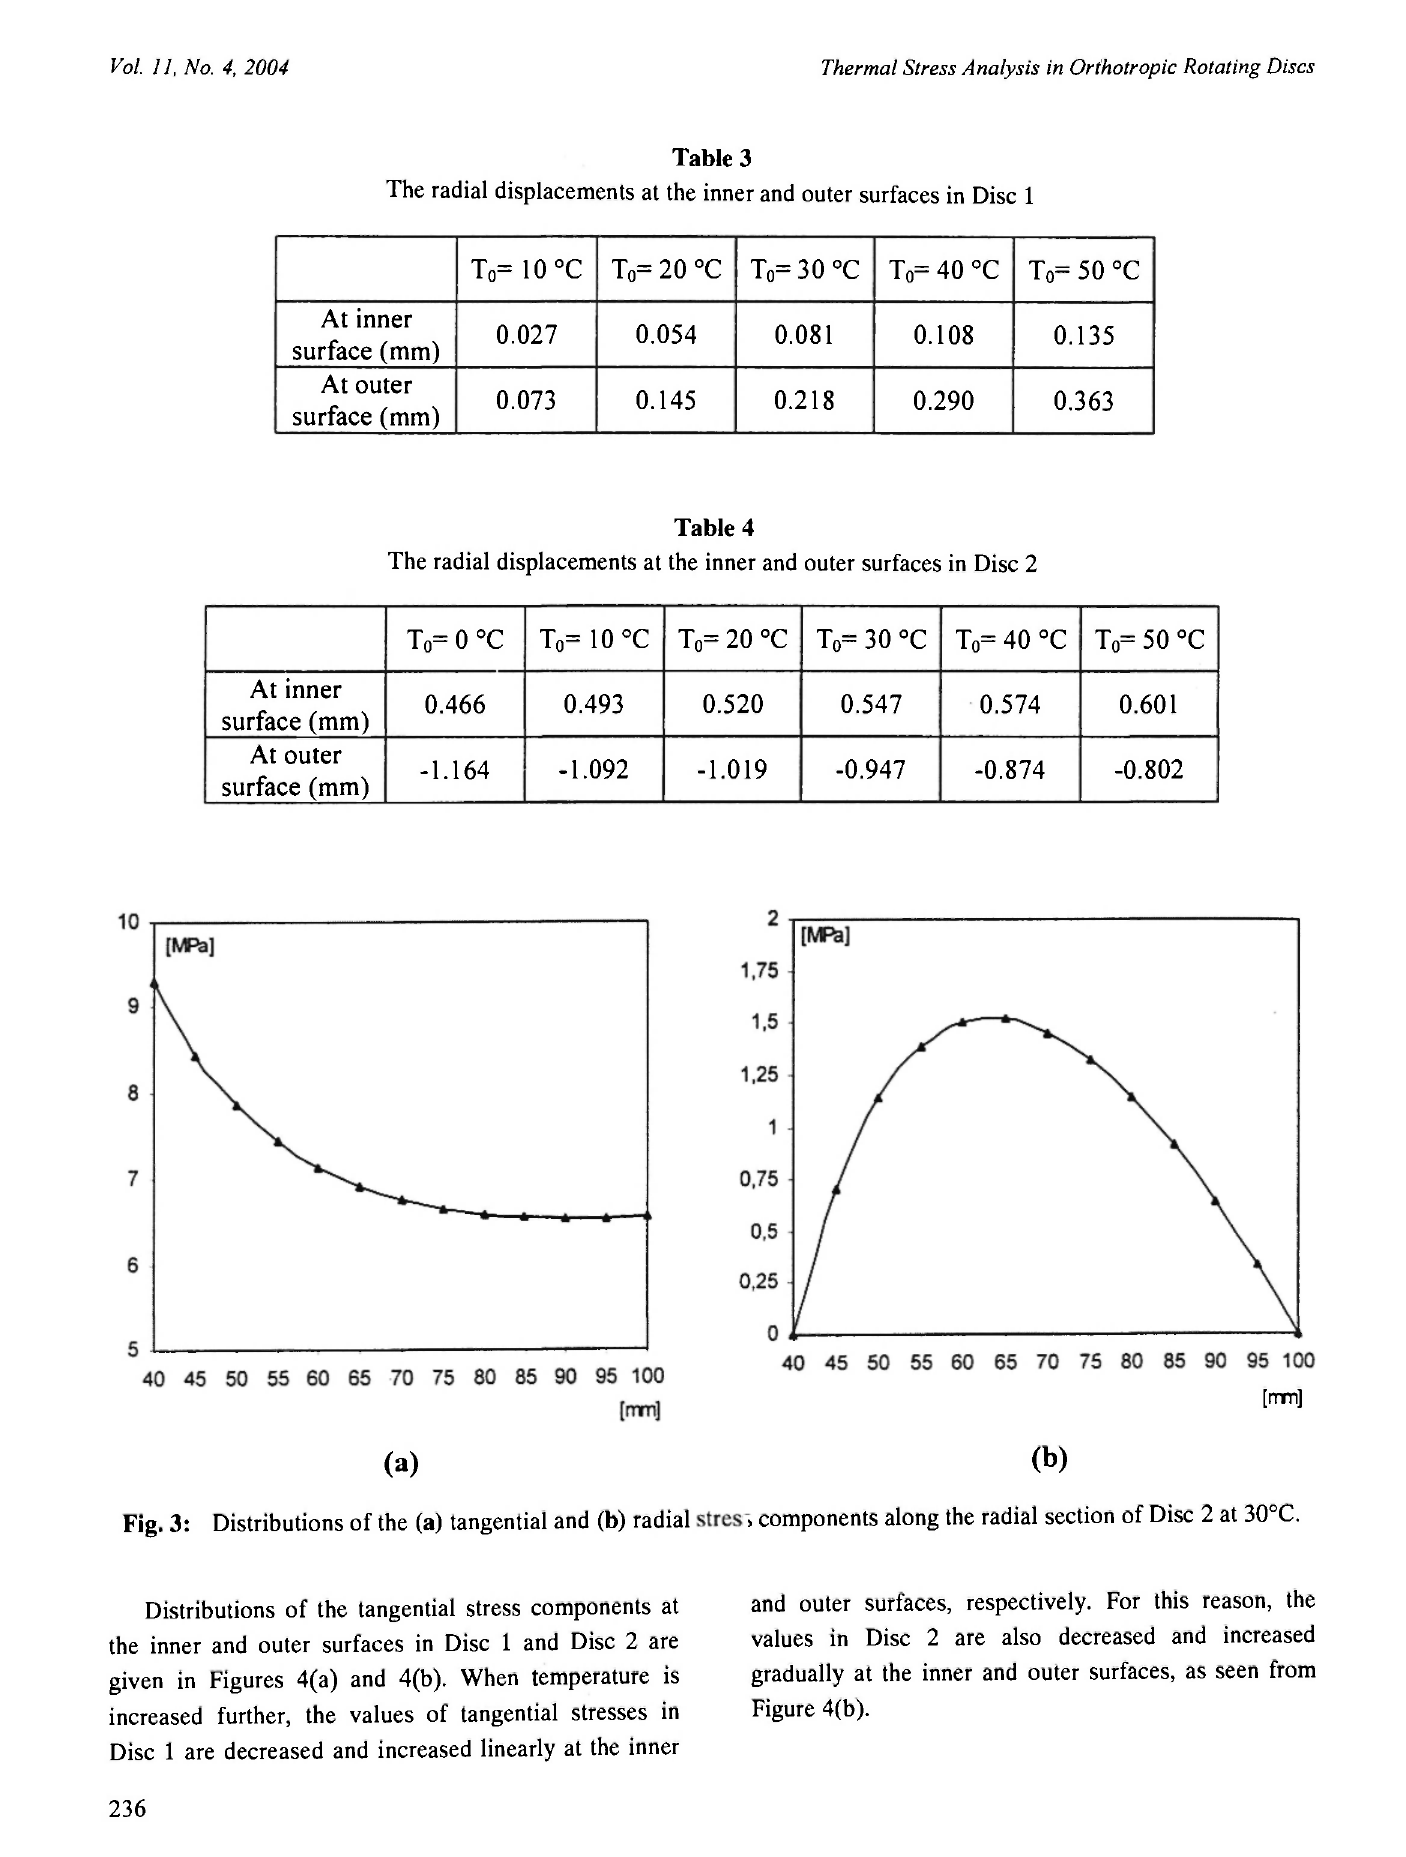
and outer surfaces, respectively. For this reason, the values in Disc 2 are also decreased and increased gradually at the inner and outer surfaces, as seen from Figure